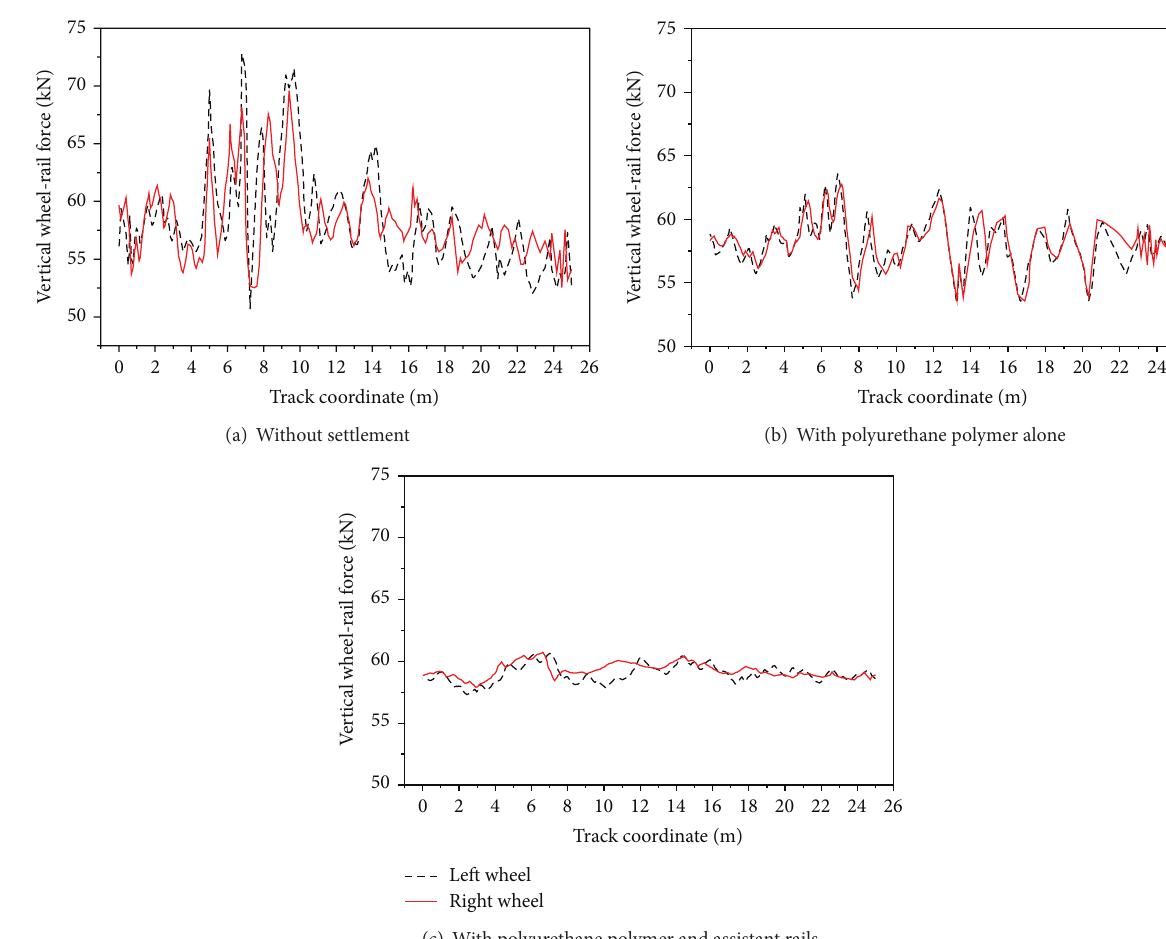
Table 2: Maximum wheel-rail contact forces and reduction ratios for different settlement patterns.